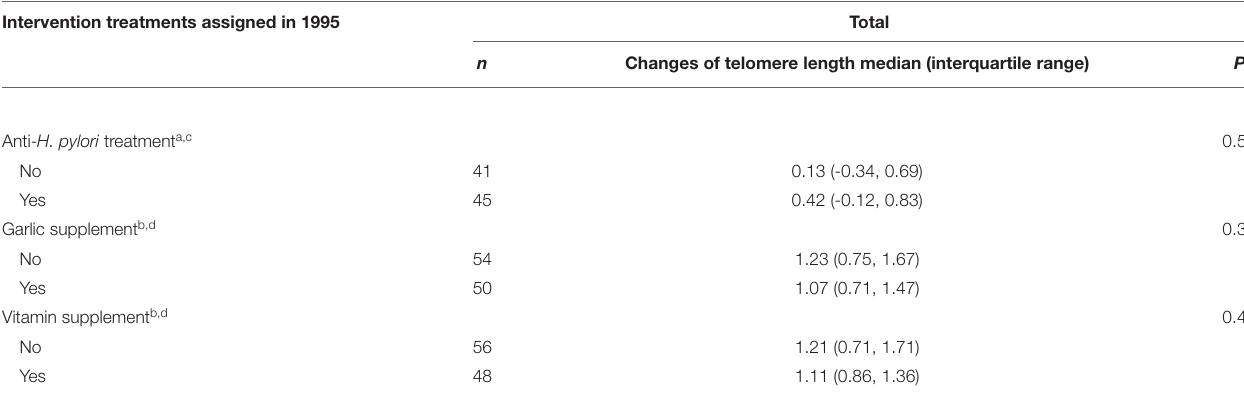
TABLE 3 | Changes of cfDNA telomere length after